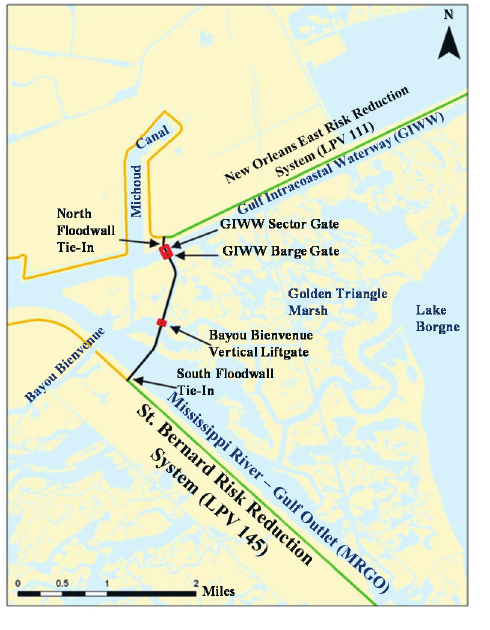
Figure 7. Map from open source of the Lake Borgne surge barrier [15].